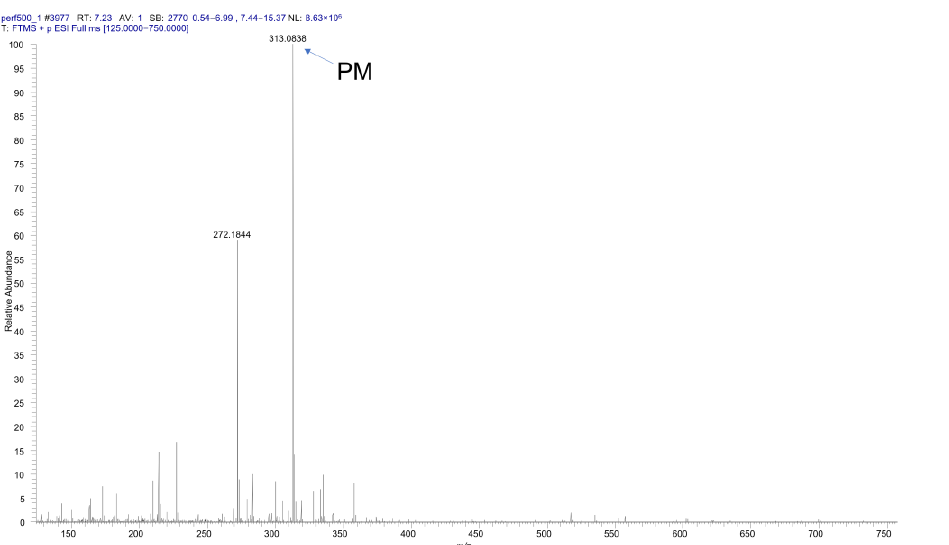
Figure A6. HRMS spectrum of paracetamol mercapturate generated in rat small intestine luminal after 90 min of perfusion.